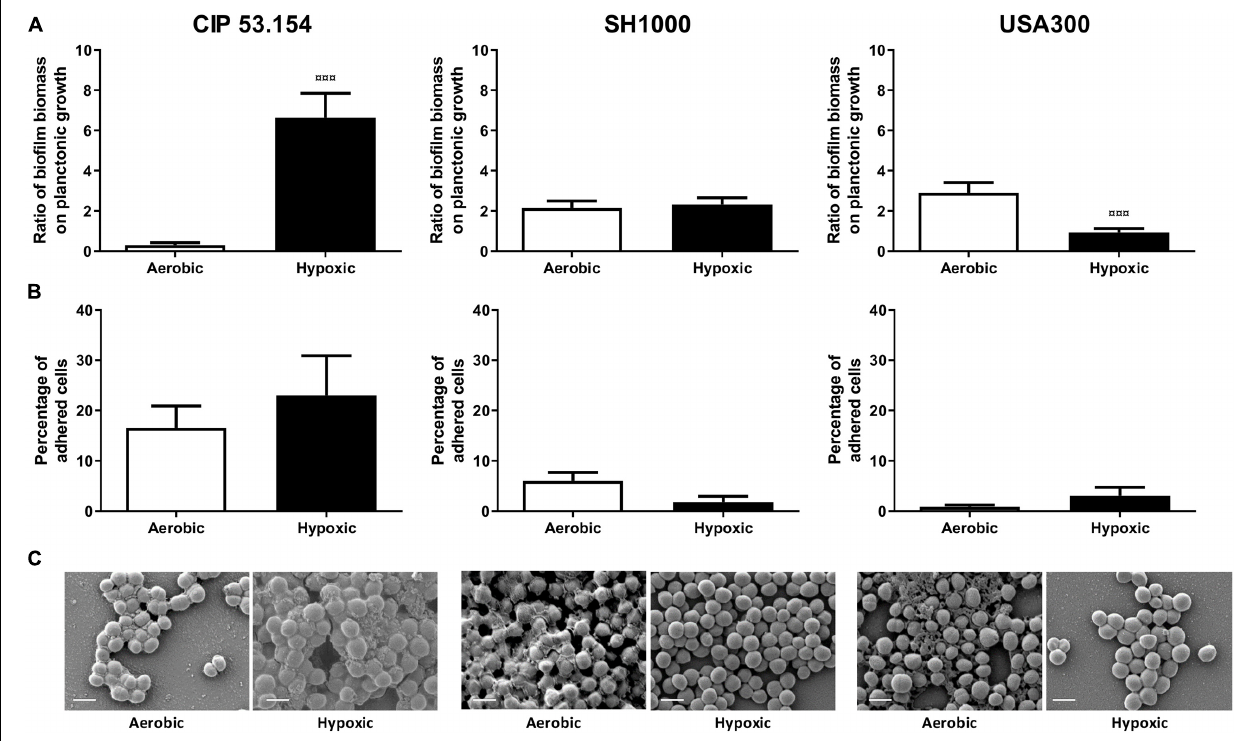
FIGURE 2 | Impact of hypoxia on S. aureus biofilm formation. Biofilms were grown in minimal medium with (white histograms) or without (black histograms) oxygen for 24 h before absorbance measurement, live adherent bacteria numeration, and scanning electron microscopy acquisition. (A) Results represent the ratio of crystal violet absorbance (biofilm biomass) on planktonic growth absorbance. Experiments were performed at least four independent times with three technical replicates for each. (B) Results represent the percentage of live adherent bacteria among all bacteria. Experiments were performed at least four independent times with two technical replicates for each. Error bars represent standard errors for each average value. (C) Representative images of scanning electronic microscopy acquisitions at 15,000 × are shown. Statistical analyses were performed using the exact non-parametric Wilcoxon–Mann–Whitney test for independent samples: ¤¤¤Statistically different from aerobic culture condition ( p < 0.001). The scale bars indicate 1 µ m.